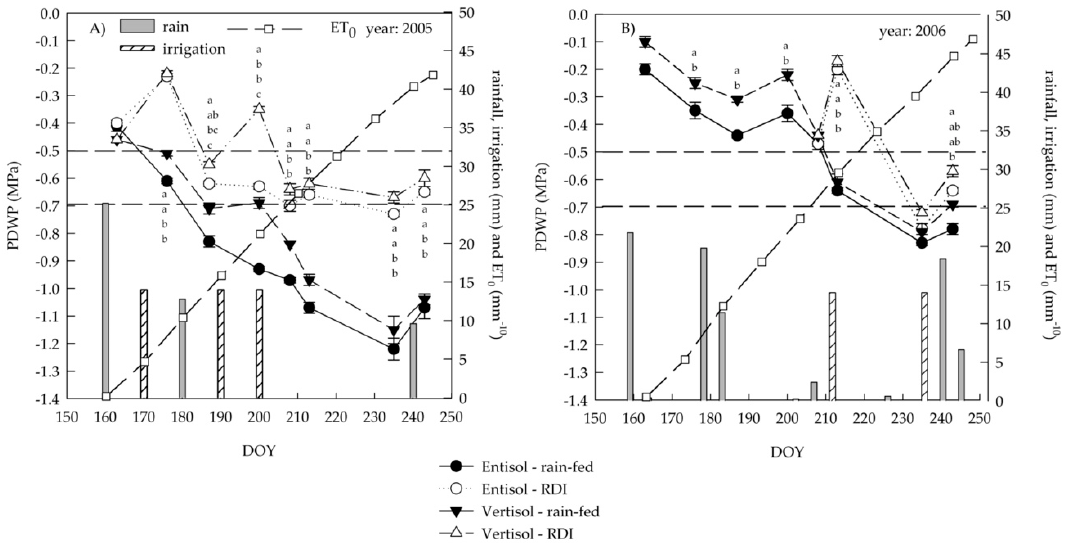
Figure 1. Seasonal variation (DOY, day of the year) in predawn leaf water potential (PDWP) of ‘Nero d’Avola’ grapevines grown in two soils (entisol and vertisol) under rain-fed and regulated deficit irrigation (RDI) treatments in 2005 ( A ) and 2006 ( B ). Bars show rainfall and irrigation events. Cumulative ET 0 is shown from pea size phenological stage (DOY 160) to ten days before harvest (DOY 245). In 2006, the irrigation started at the end of July (DOY 206). Error bars indicate standard errors ( n = 12). Dashed horizontal lines indicate the PDWP threshold values for irrigation. When present, different letters indicate significant differences among treatments for a specific date (Tukey’s multiple range test, p < 0.05).